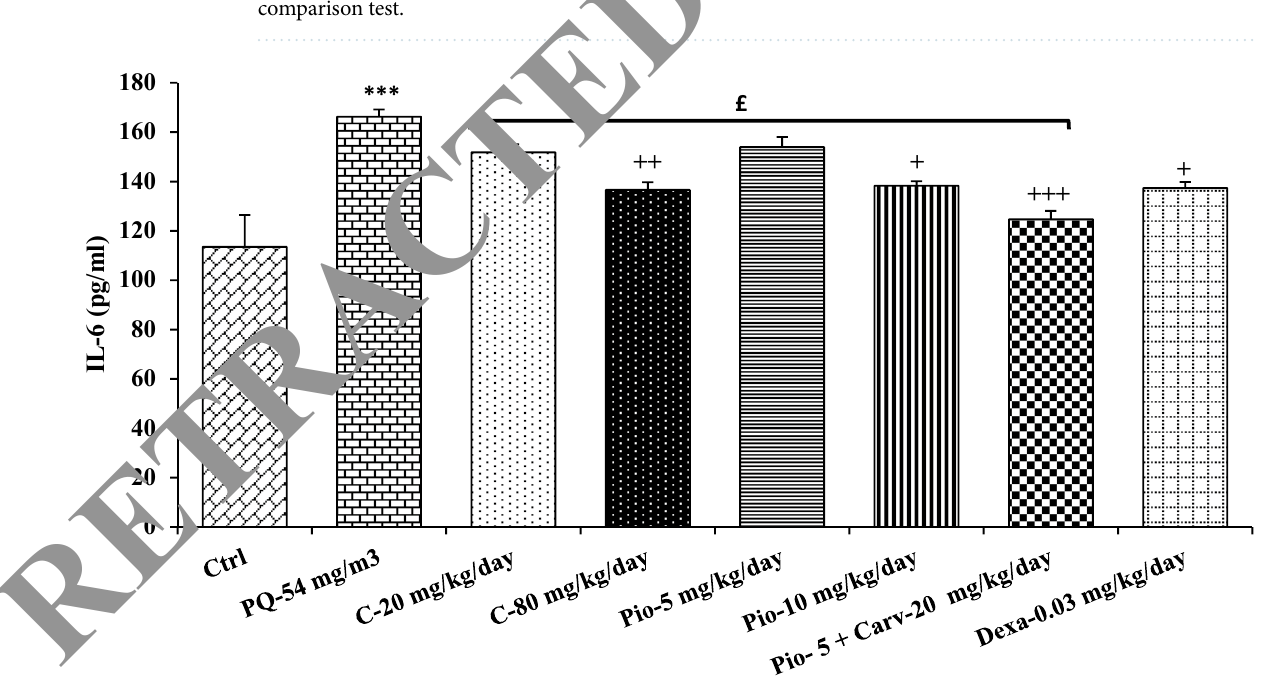
Figure 7. Comparison of IL-6 level between control group (Ctrl), group exposed to paraquat aerosol at doses of 54 mg/m 3 (PQ-54 mg/m 3 ), groups exposed to PQ-54 mg/m 3 and treated with 5 and 10 mg/kg/day pioglitazone (Pio-5 mg/kg/day and Pio-10 mg/kg/day), 20 and 80 mg/kg/day carvacrol (C-20 mg/kg/day and C-80 mg/ kg/day), 0.03 mg/kg/day dexamethasone (Dexa 0.03 mg/kg/day) and 5 mg/kg/day pioglitazone + 20 mg/kg/ day carvacrol (Pio-5 mg/kg + C-20 mg/kg). *** p < 0.001 compared to the control group. + p < 0.05, ++ p < 0.01, and +++ p < 0.001 compared to the PQ-54 mg/m 3 , £ p < 0.05comparison between Pio-5 and C-20 with Pio-5 mg/ kg/day + C-20 m g/kg/day group. Data are presented as mean ± S EM (n = 6 in e ach group). Comparisons between different groups were made using one-way ANOVA followed by Tukey’s multiple comparison